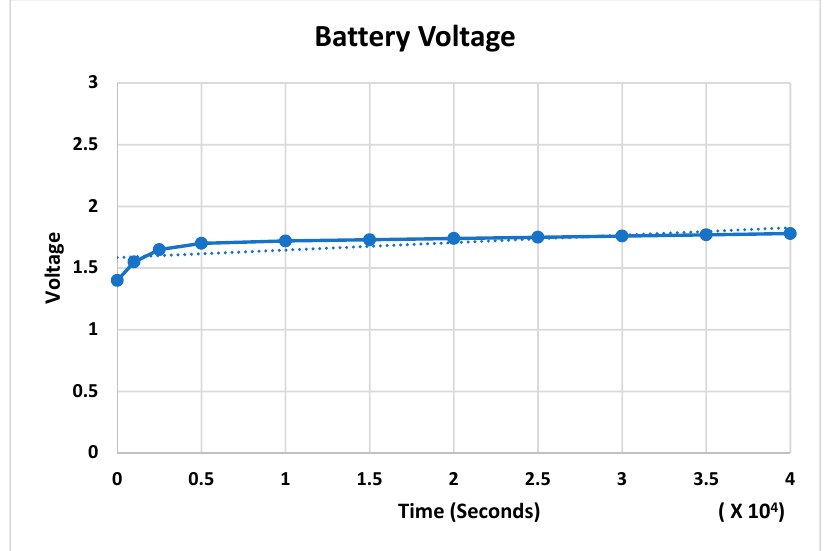
Figure 20. Charging/Battery Voltage for the Designed Circuit.